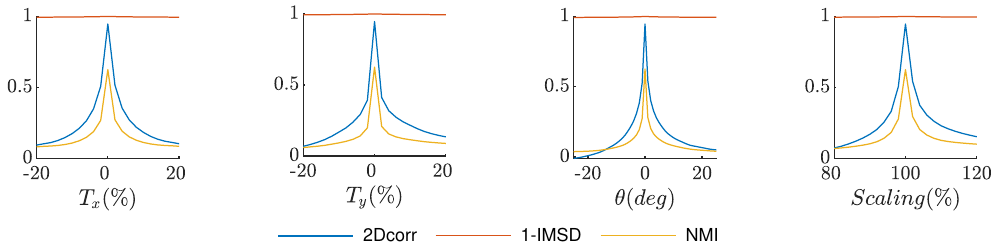
Figure 9. Metric response to independent camera movement components under realistic operation conditions, i.e., when each video frame is compared to the stable version of the previous frame. Averaged values along all studied video sequences. Camera movement components are: translation in the X direction ( T x ), translation in the Y direction ( T y ), rotation ( θ ) and scaling. 1-IMSD is displayed for consistency with the rest of